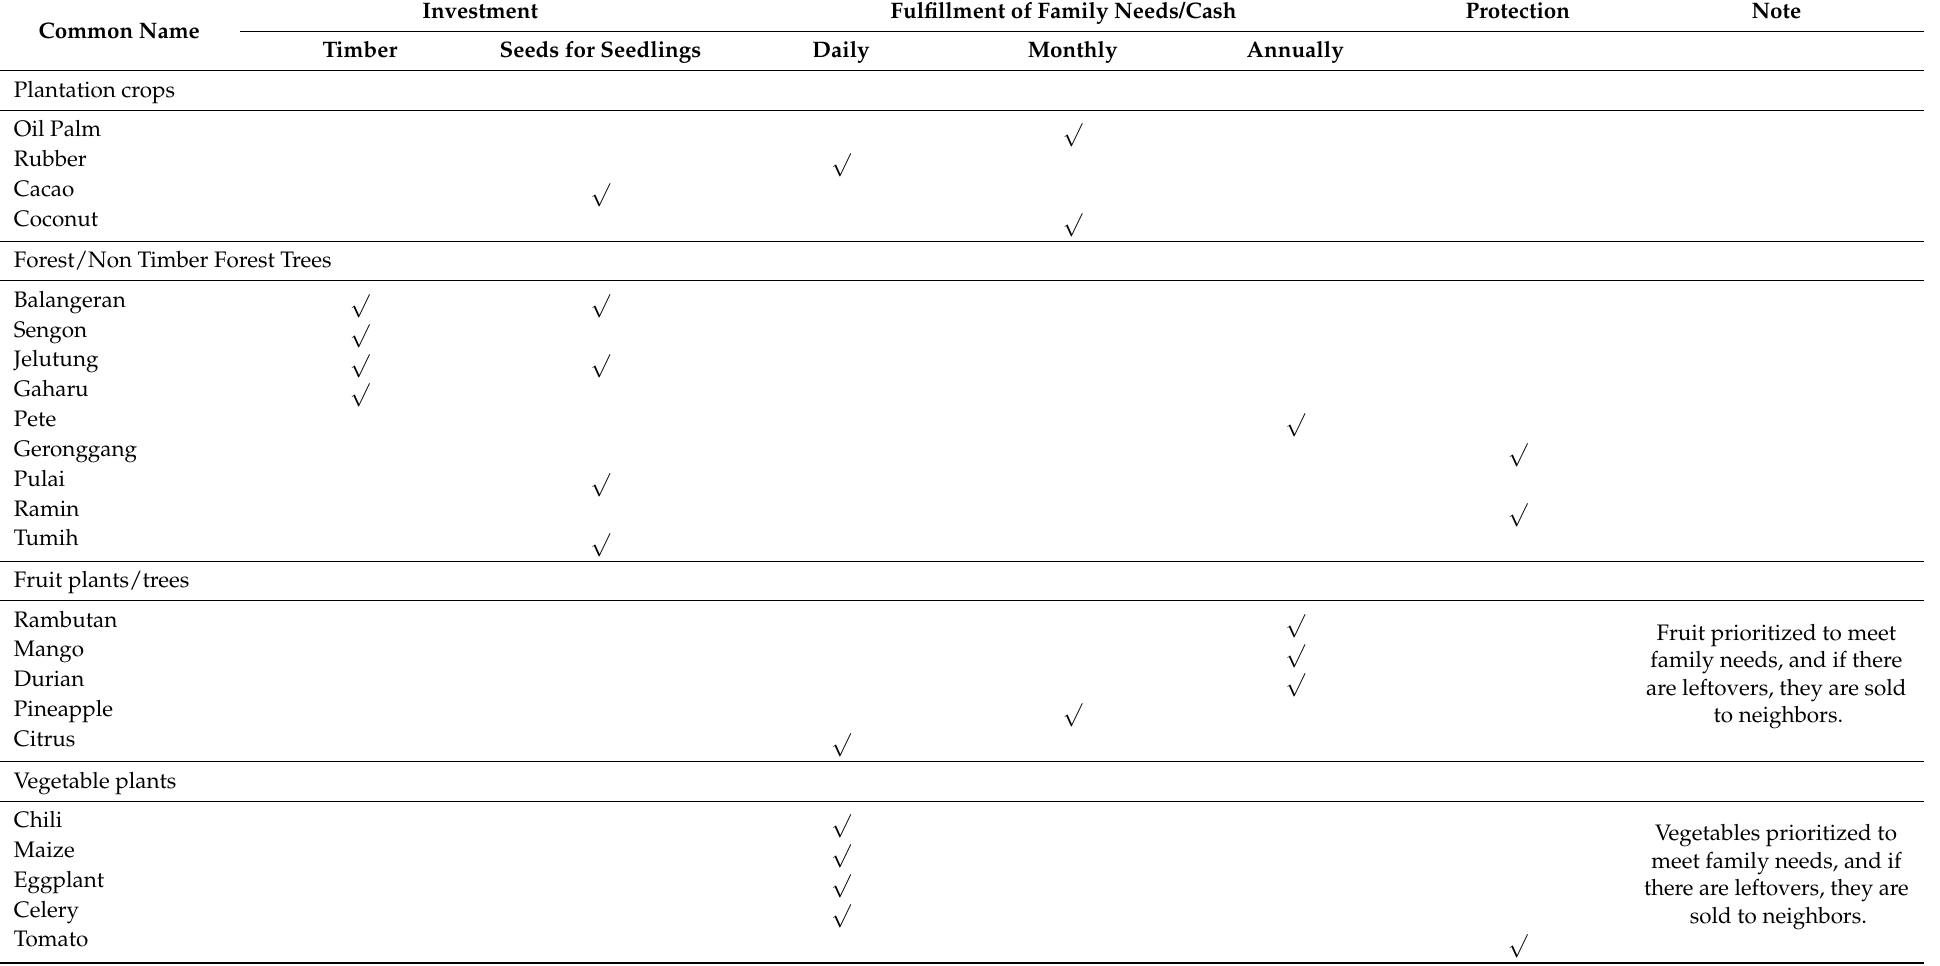
Table 3. Reasons noted by respondents for choice of species planted in their home